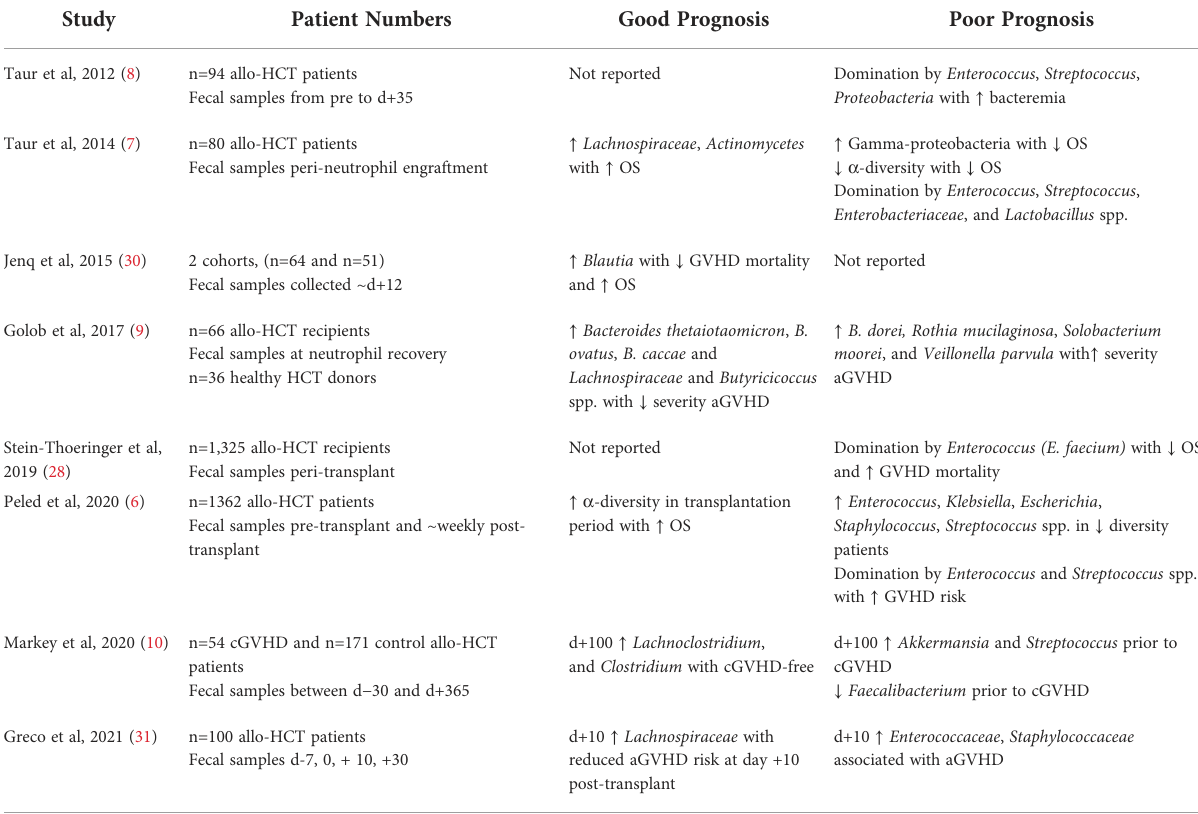
TABLE 1 Clinical Data Associating Microbial Features with Transplant